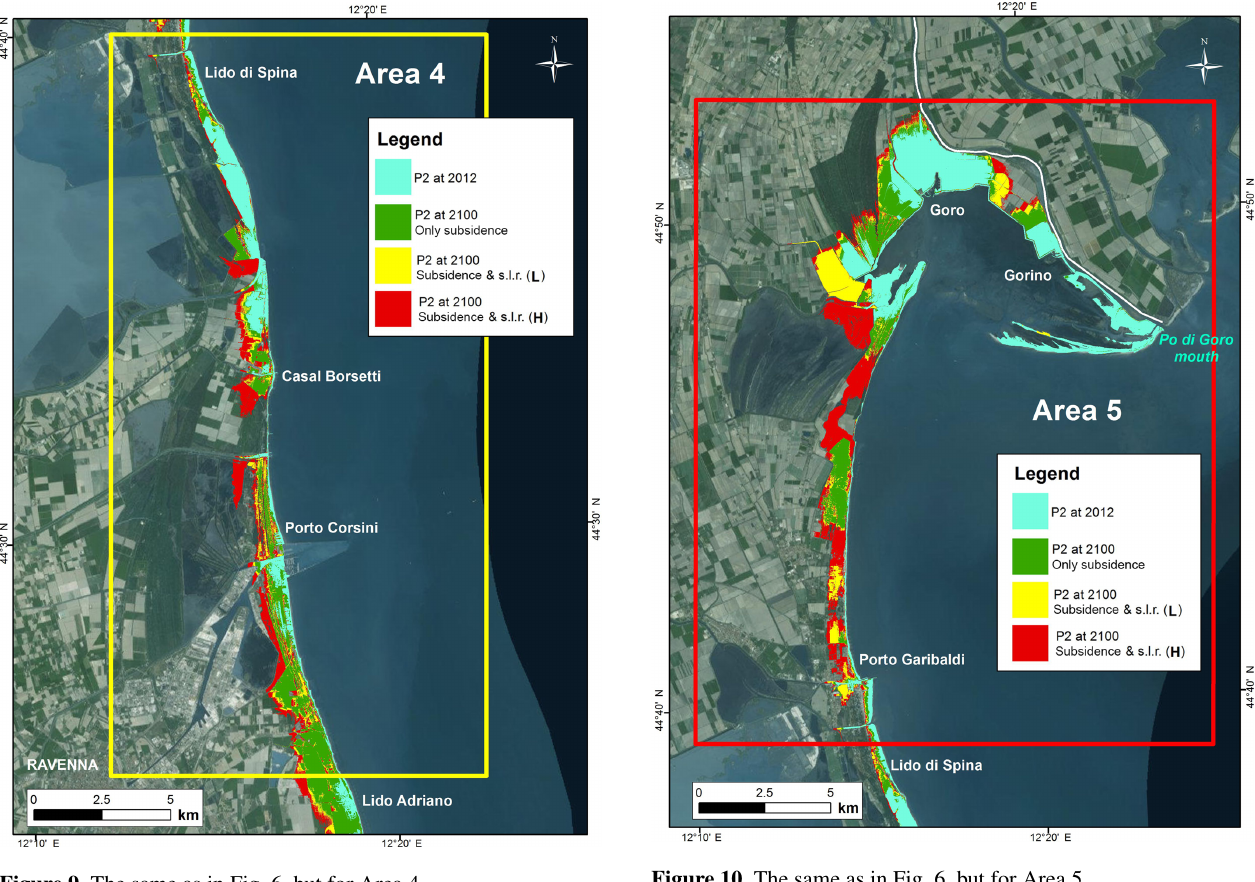
Figure 9. The same as in Fig. 6, but for Area 4. Table 7. Regional floodable areas in the case of storm surges for case P2 described in Table 4. The increase in the flooded area is relative to P2-DTM12.